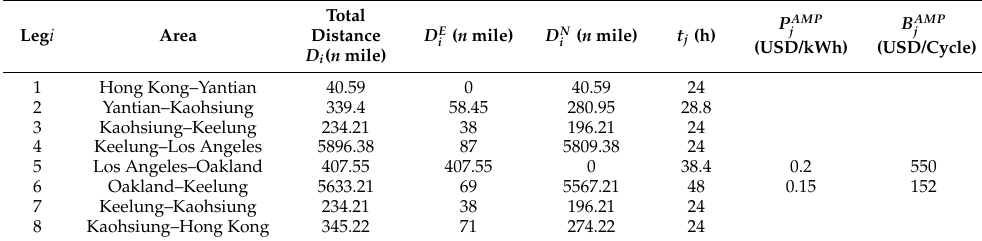
Table 2. Leg summary and AMP subsidy policies.